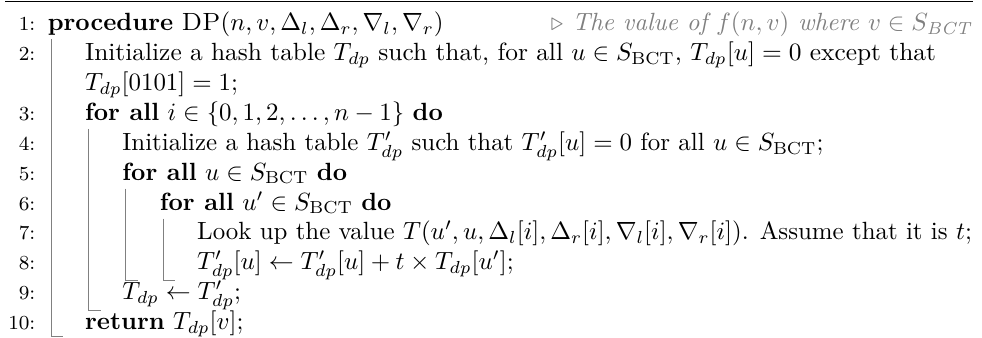
Algorithm 1 A dynamic programming algorithm to compute f